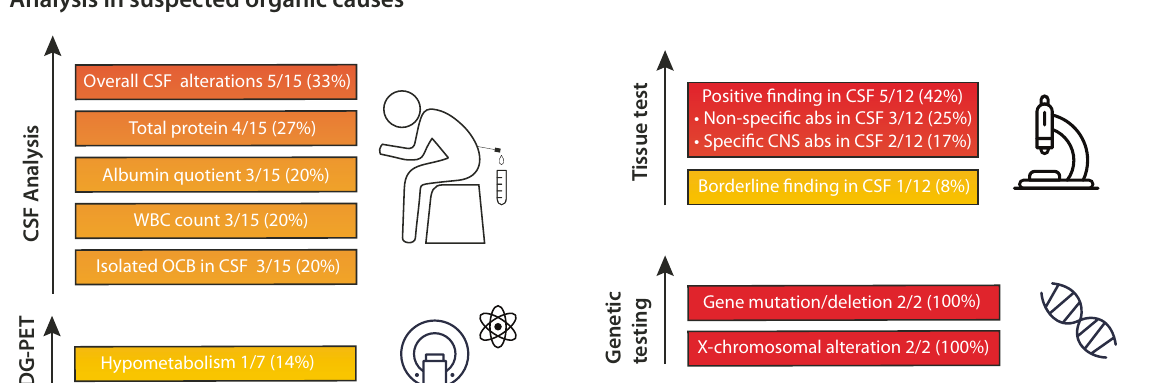
Fig. 2 Prevalence of laboratory, MRI, and EEG alterations in OCD patients. Elevated parameters are displayed in yellow/orange/red depending on level of elevation. Decreased parameters are displayd in blue tones. CH50 complement hemolytic activity, CSF Cerebrospinal fl uid, DNAse Deoxyribonuclease, EEG Electroencephalogram, GM gray matter, MRI magnetic resonance imaging, OCB oligoclonal band, PTT Partial thromboplastin time, TG Thyroglobulin, TPO Thyroid peroxidase, WBC white blood